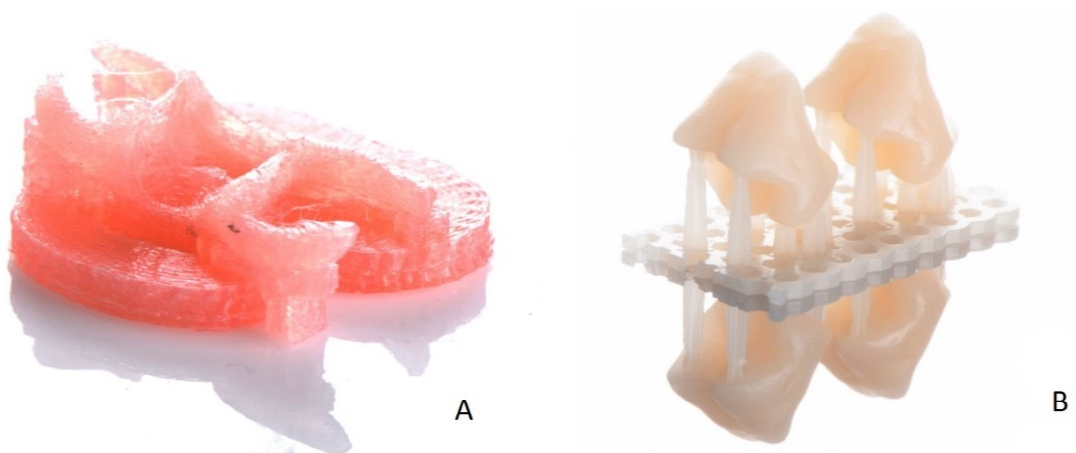
Figure 2. ( A ) The virtual design of the denture base in the CAD software (Dental CAD, Exocad, Darmstadt, Germany) with the applied pontic tooth, using the “attachment” function. ( B ) The final denture design with a corresponding retention socket for the pontic tooth.